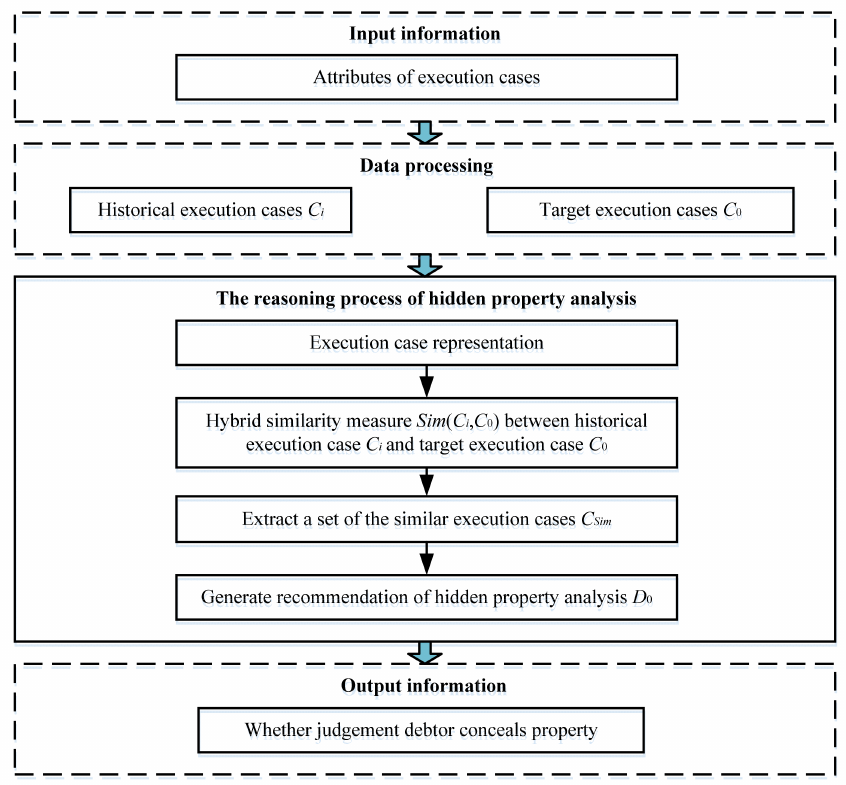
Figure 1. Flowchart of CBR for hidden property analysis of judgment